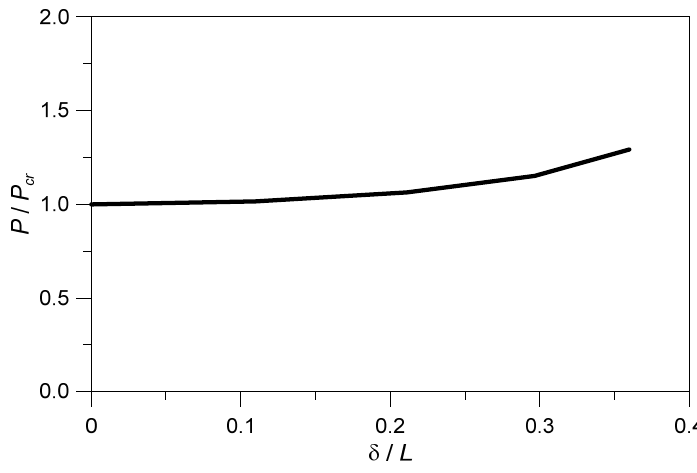
Figure 4. Normalised load-deflection curve.